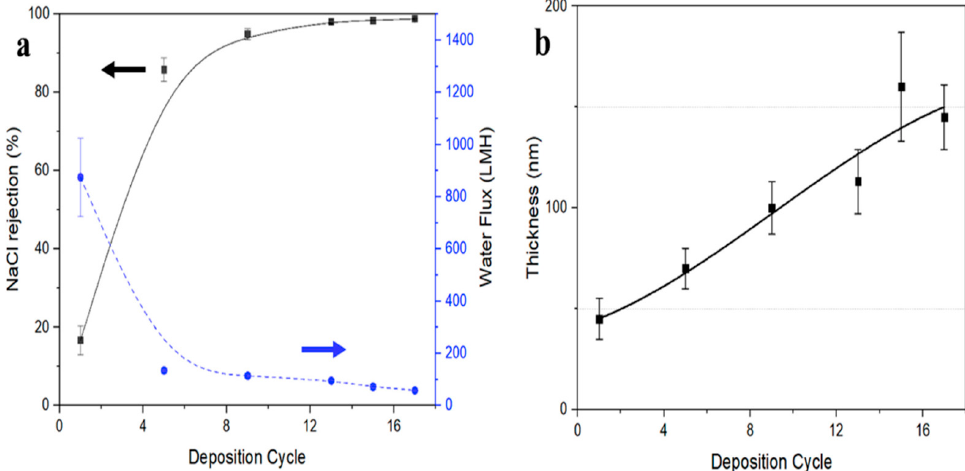
Figure 8. Performance of the PA/outer-wall membrane. ( a ) Water flux and NaCl rejection as a function of the number of PA formation cycles on outer-wall VA-CNT support membrane, ( b ) Thickness of PA layer on outer-wall VACNTs support membrane as a function of number of PA formation cycles (Reproduced with permission from Elsevier; adapted from Li et al., 2019 [67]).The most widely used RO membrane has a rejection rate of 98.4% and has a water permeability of 0.4–3.2 LMH · bar − 1 , whereas the proposed VA-CNT-based membrane showcases a permeability of 4.7 ± 0.7 LMH · bar − 1 , which is most likely caused by the weak interfacial force of water molecule and hydrophobic